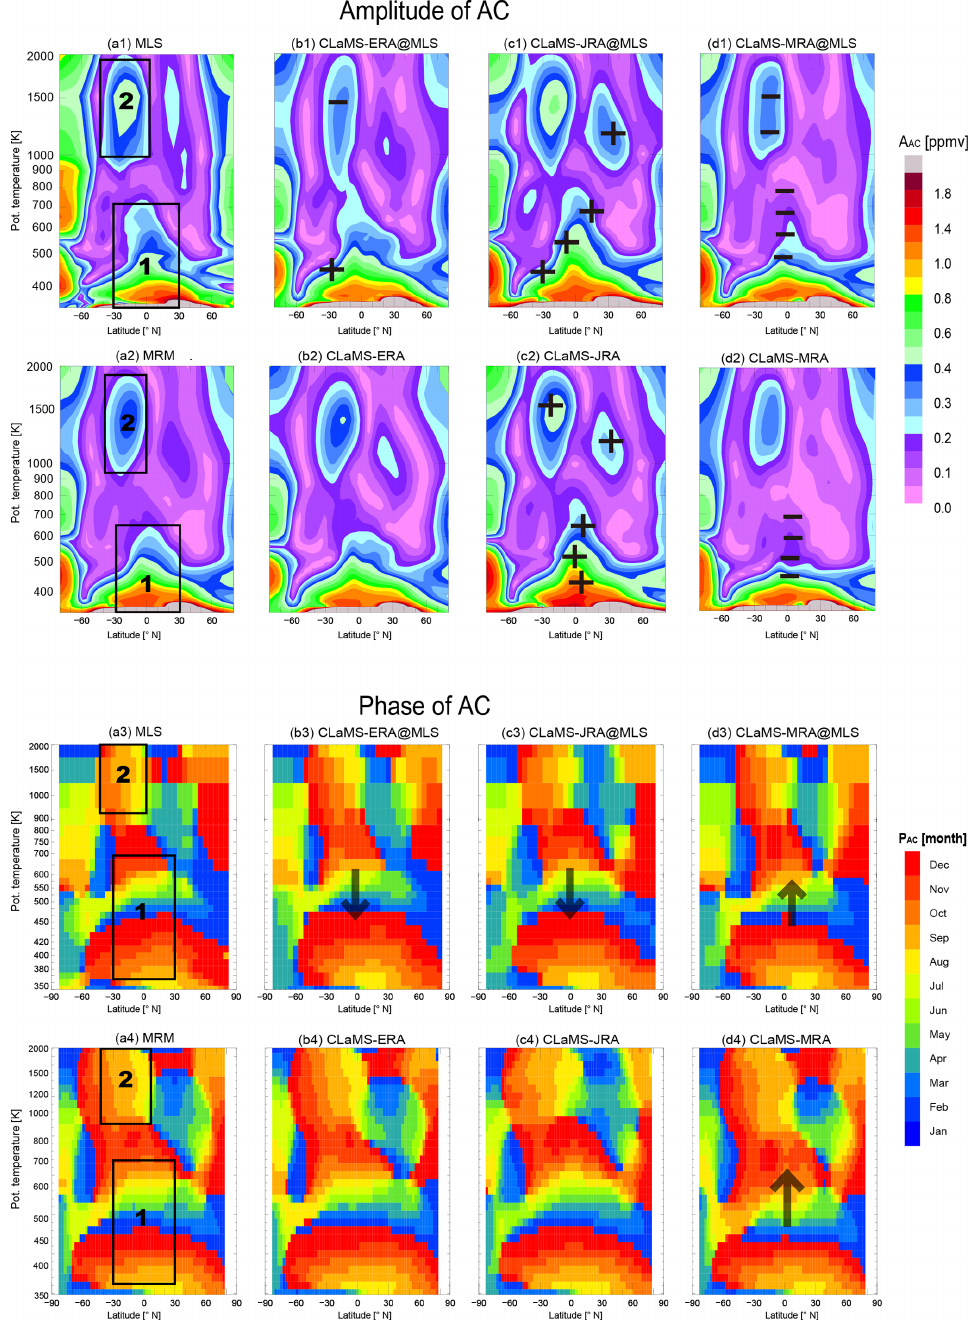
Figure 7. AC amplitudes ( A AC ) and corresponding phases ( P AC ) during the MLS period ( ∼ 2005–2013, the first and third rows) and the entire CLaMS period (1980–2013, the second and fourth rows). The leftmost panels show A AC and P AC based on Aura MLS observations (a1, a3) and the mean of the three reanalysis-driven models (MRM, a2 , a4 ). The corresponding A AC values from CLaMS-ERA, CLaMS-JRA and CLaMS-MRA are shown in the rightmost three panels of each row. Overlaid “ + ” and “ − ” symbols in panels (b1) – (d1) and (b2) – (d2) demonstrate major differences by more than ± 30% in simulated A AC relative to the benchmark estimate shown in the corresponding leftmost panel. Arrows in panels (b3) – (d3) and (b4) – (d4) indicate the major region with phase differences by more than 1 month against the benchmark estimate of P AC shown in the corresponding leftmost panel. The upward arrows show phase lagging behind of the benchmark phase while the downward arrows show phase ahead of the benchmark